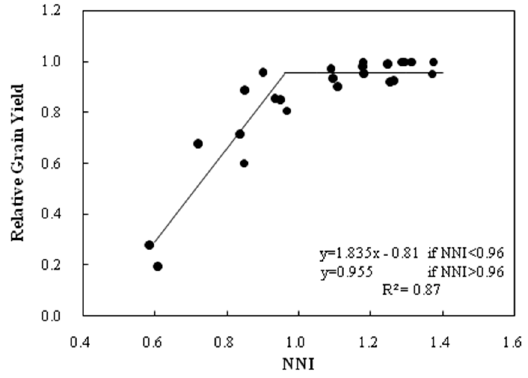
Figure 4. Relationships between relative grain yield and the N nutrition index (NNI) of spring maize. The NNI data were averaged over all sampling dates (V7, V8, V9, and V10).